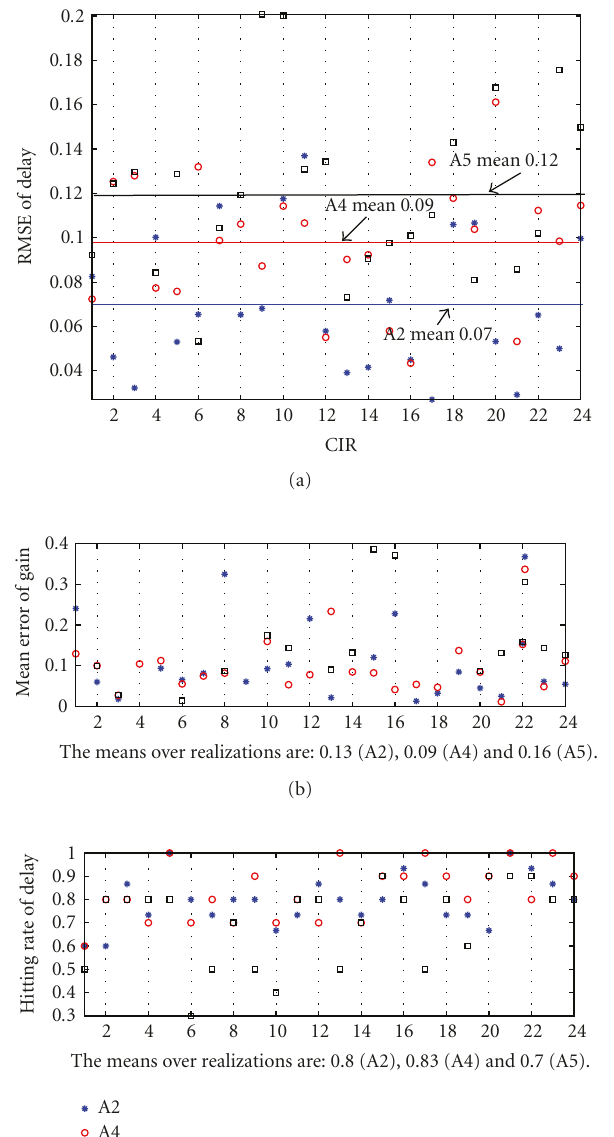
Figure 7: Performance of estimates in the noise-free case when T = 0 . 3 t p , p = 10, L = 50, and M = 60. From top to bottom: normalized RMSEs of the delay estimates, mean errors of the gain estimates and hit rates of the delay estimates. The horizontal axis in each subplot represents CIR realizations.